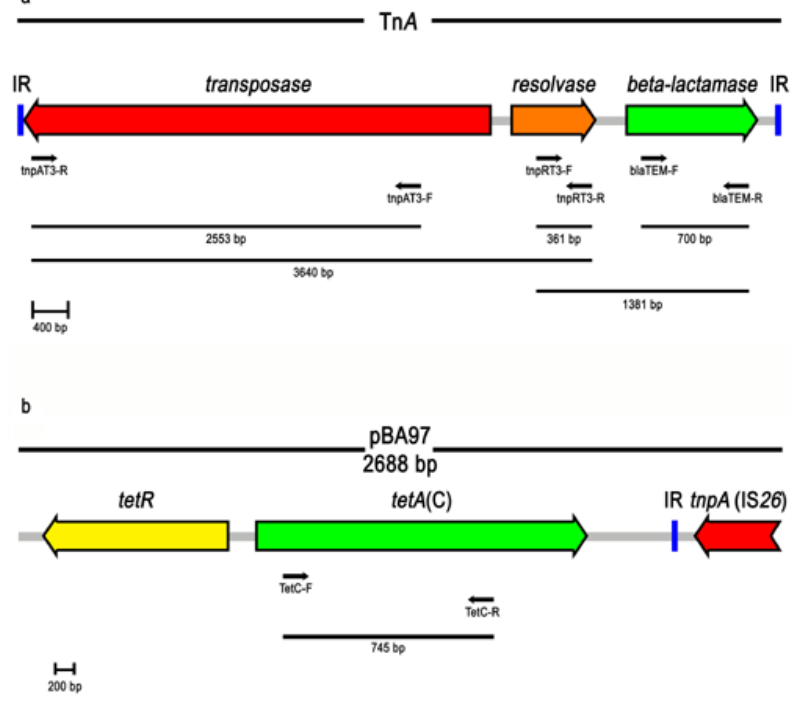
Figure 2. Schematic representation of both TnA family transposon ( a ) and pBA97 construct ( b ) (GenBank accession numbers V00613 and GU987054, respectively). Direction of transcription is indicated by thick arrows. The primers and their directions are represented by narrow arrows. The horizontal bars and their sizes represent the DNA fragments yielded by different primer